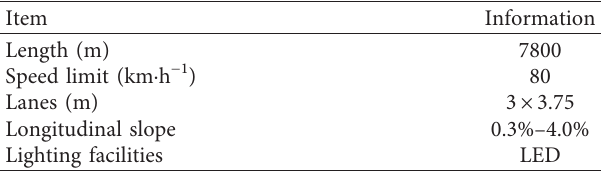
Table 1: The information of Qingdao Jiaozhou bay tunnel.